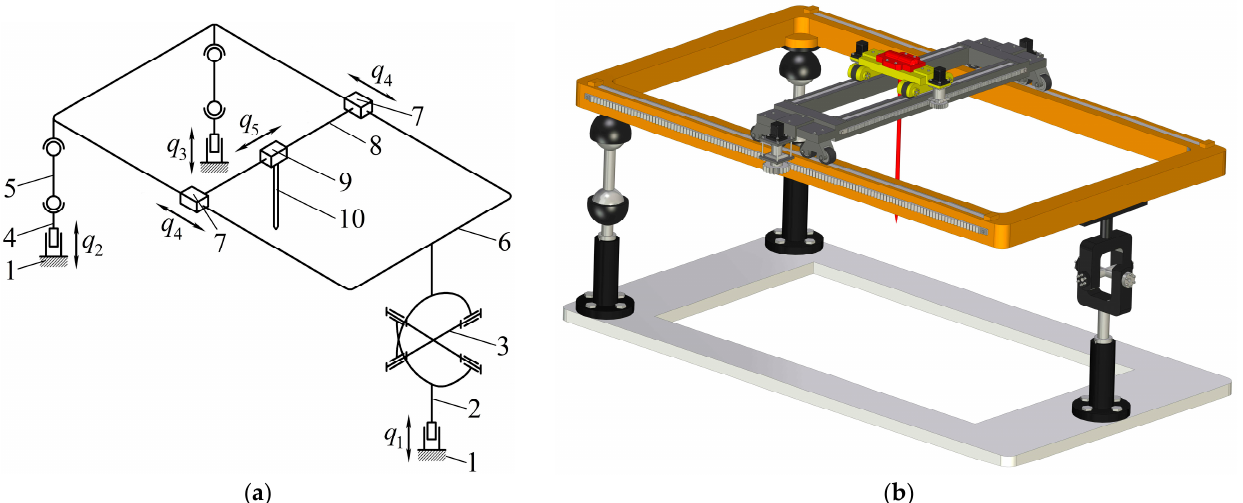
Figure 1. 5-DOF (3T2R) parallel–serial (hybrid) manipulator: ( a ) structural scheme; ( b ) CAD model. Each kinematic chain (leg) of the parallel part has a linear drive that provides displacement 𝑞 (cid:2869) , 𝑞 (cid:2870) , or 𝑞 (cid:2871) . The chain with the universal joint restricts the platform